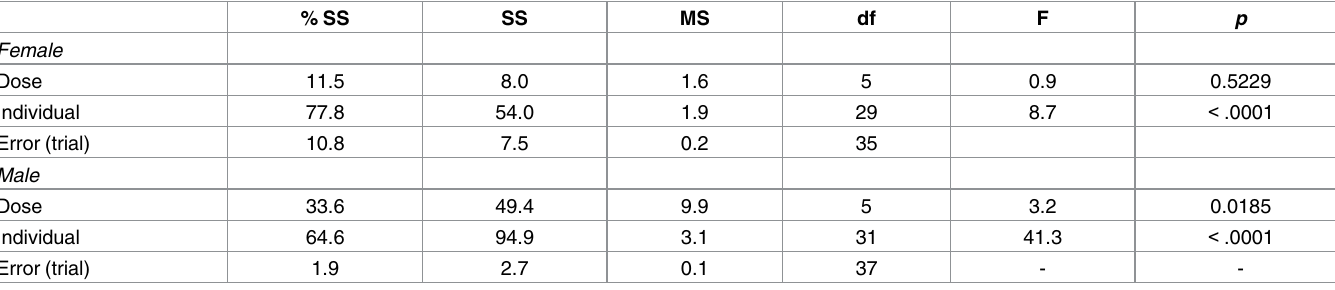
among males in the 100 mg/kg bw dose group (CS = 45.6±1.1, p = 0.055). Consistent with these results, only males showed significant effects of dose on CS ( p = 0.019), accounting for 33.6% of total variation (Table 3). In contrast, only females in the two highest dose groups experienced a significant decrease in FA compared to the control group ( p = 0.01–0.030) (Table 2). The ANOVA results for shape showed significant effects of dose and directional asymmetry (DA) in both males and females ( p < 0.001), but only males showed a significant effect of FA on shape ( p = 0.0003) (Table 4). For both sexes, individual variation and measurement trial accounted for the majority of the total variation. As illustrated by the PCA results (S2–S7 Figs), the first and second PCs (accounting for 27% and 15% of total shape variation in females and 19% and 15% of total shape variation in males, respectively) did not clearly separate most dose groups. The control and highest dose groups (1000 mg/kg bw) show some separation in their second PC scores (S2 and S3 Figs), corresponding to shortening of the face in females (S5 Fig) and elongation of the face and palate in males (S7 Fig). Table 3. Results of ANOVA for the effects of dose of PCB 180, individual, and trial on centroid size for female and male offspring on PND 84. % SS SS Female Dose Individual Male Dose